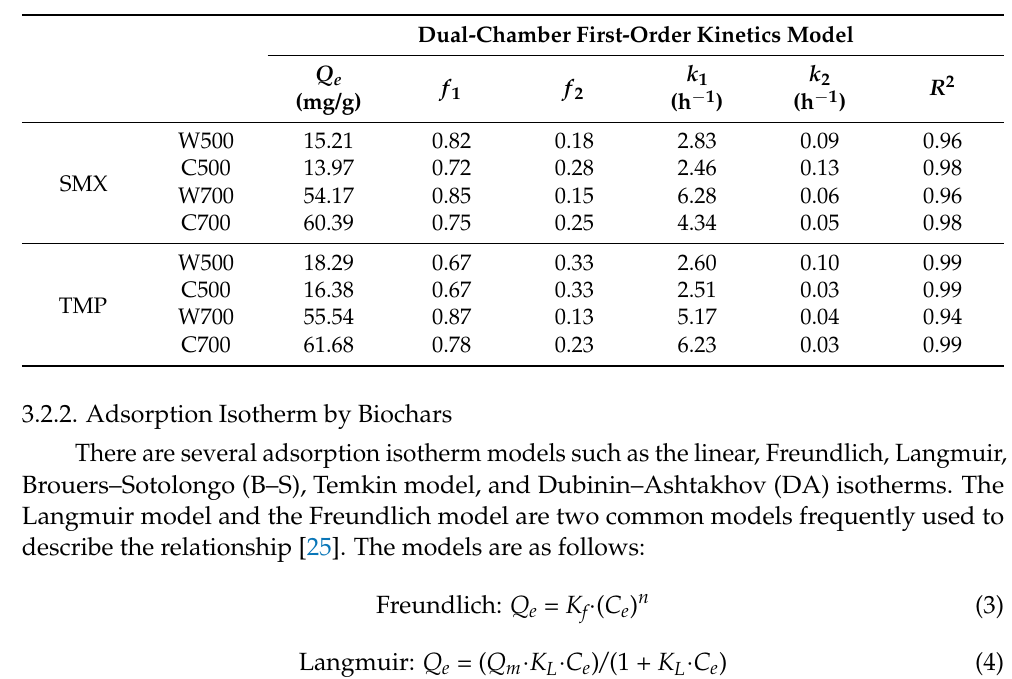
Table 3. Model results of adsorption kinetics